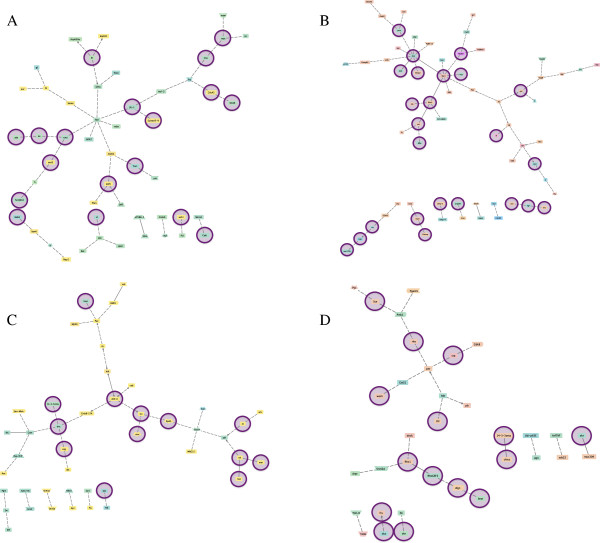
Predicted co-citation networks from Backx et al.[46]gene list for 4-, 6-, 8-, and 10-day-old workers (A-D, respectively). Description of symbols and topography is as for Figure 1, with the exception of a colour code change: genes ranging from yellow to pink are up-regulated in ovary in-active bees and genes ranging from yellow to green are down-regulated in ovary active bees.